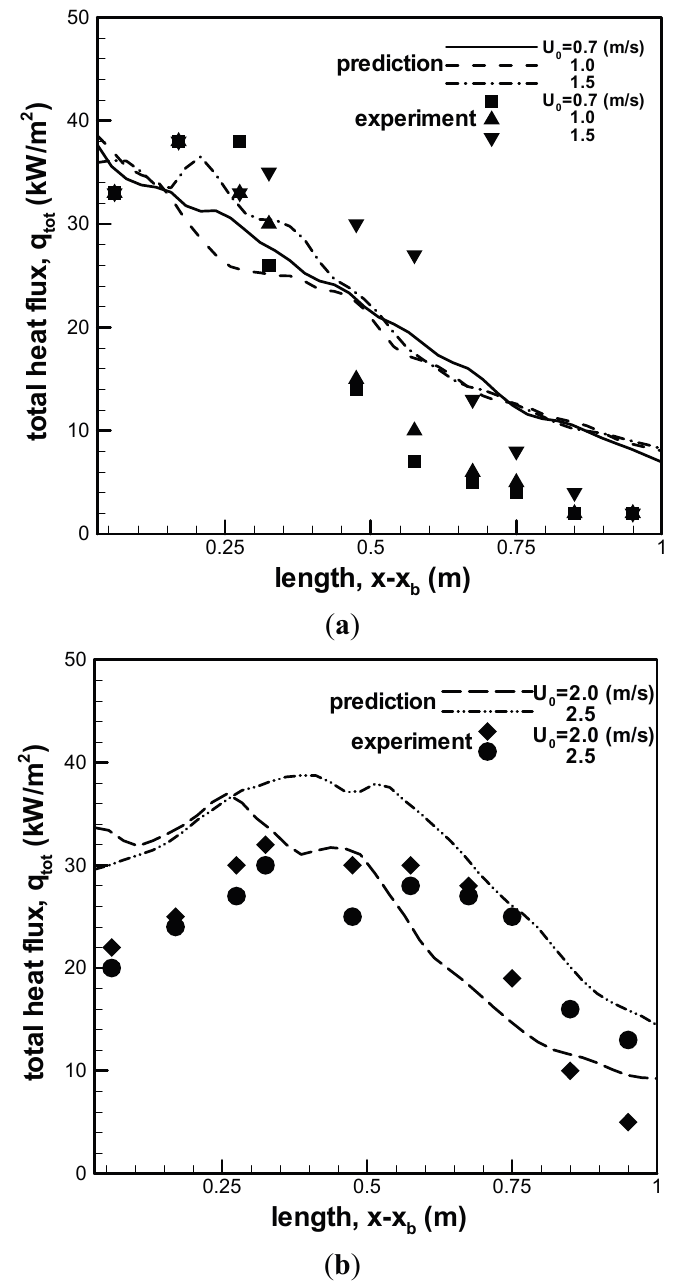
Figure 10. Comparison between predicted and measured total heat flux from the flame to the wall surface downstream behind the burner. ( a ) Heat flux for U 0 = 0.7, 1 and 1.5 m/s; ( b ) heat flux for U 0 = 2 and 2.5